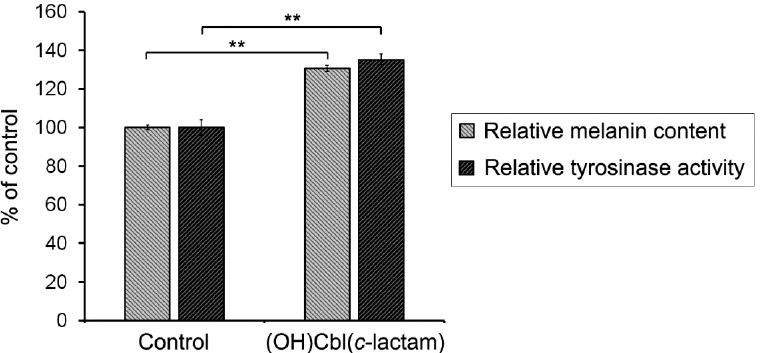
Figure 4. Effect of cobalamin deficiency on melanogenesis. Melanin content and tyrosinase activity in HEMn-DP cells were determined following 24 days of cell culture in medium supplemented with (OH)Cbl( c -lactam) in concentration of 10 µ g/mL. The obtained results were calculated as the percentage of control (melanocytes cultured in parallel in standard growth medium). Data presented as the mean values of three independent experiments ± SD; asterisks denote significant differences from the control (** p < 0.01).